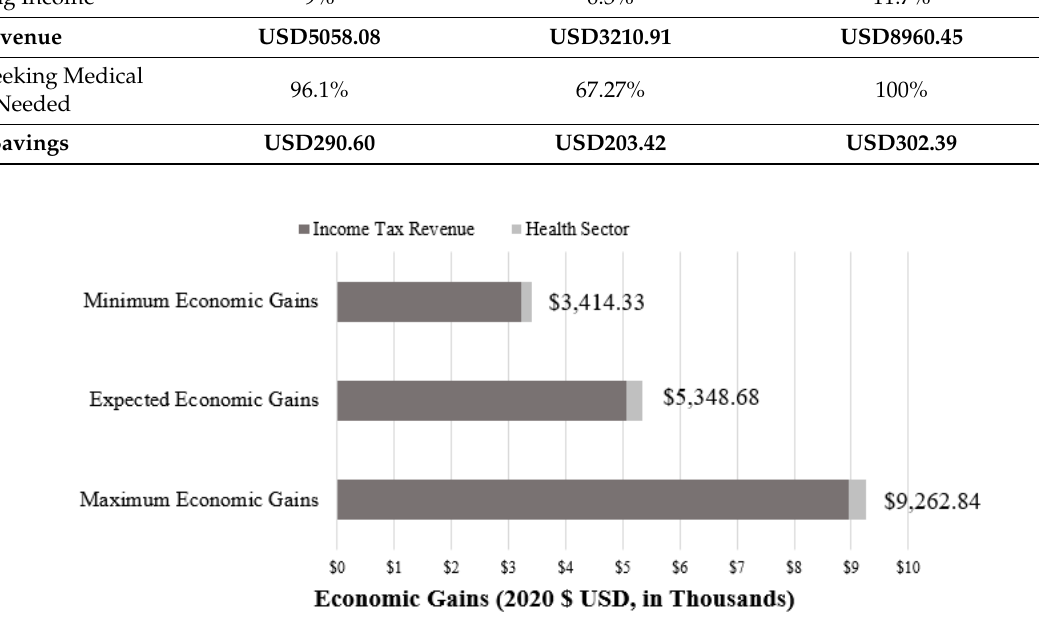
Figure 2. Annual economic gains per sex worker in sensitivity analysis (monetary values in 2020 USD).